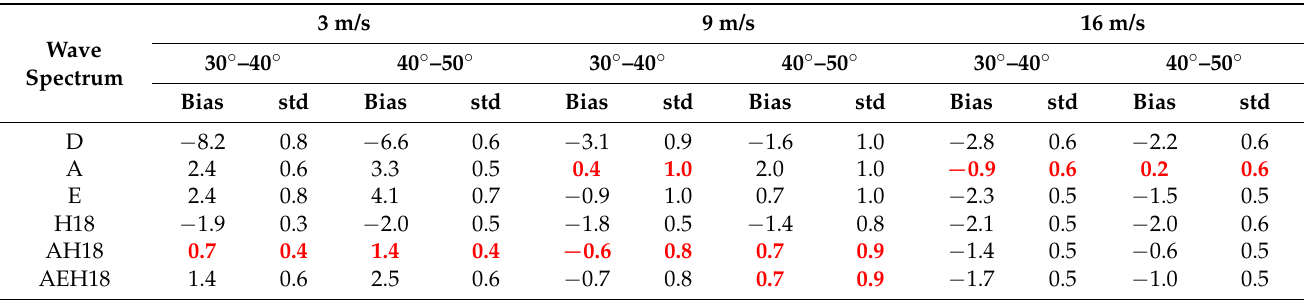
Table 1. The offset (bias) and standard deviation (std) of the simulated NRCS shown in Figure 8 relative to CMOD5.n.